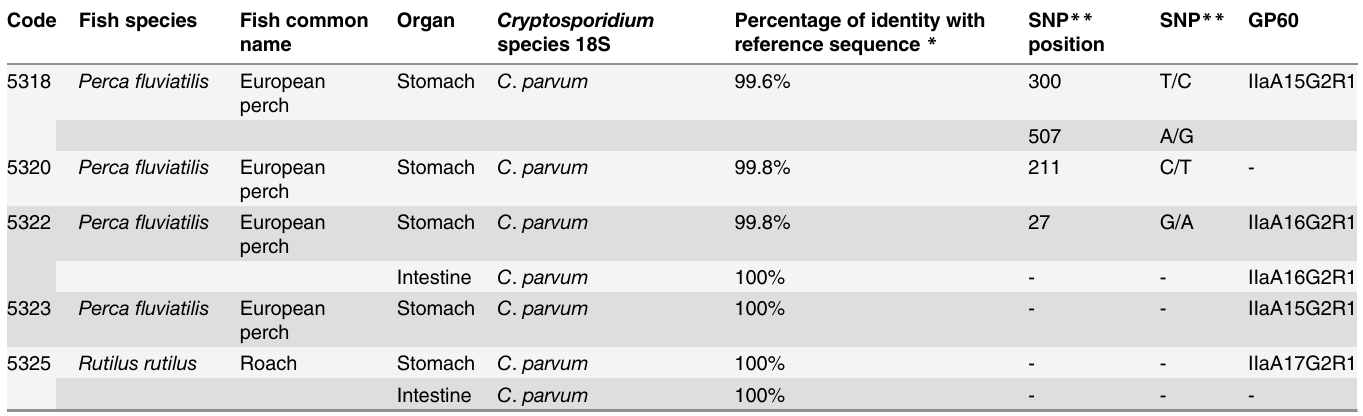
The potential contamination of fish flesh with Cryptosporidium spp. was evaluated. One hundred fish fillets of European perch ( Perca fluviatilis ) were analyzed by nested PCR and sequencing. The presence of C . molnari was detected in only one fillet. The 18S rRNA gene sequence of this C . molnari isolate was identical to that of the two isolates found in the stomach of two Northern pike (Table 2).